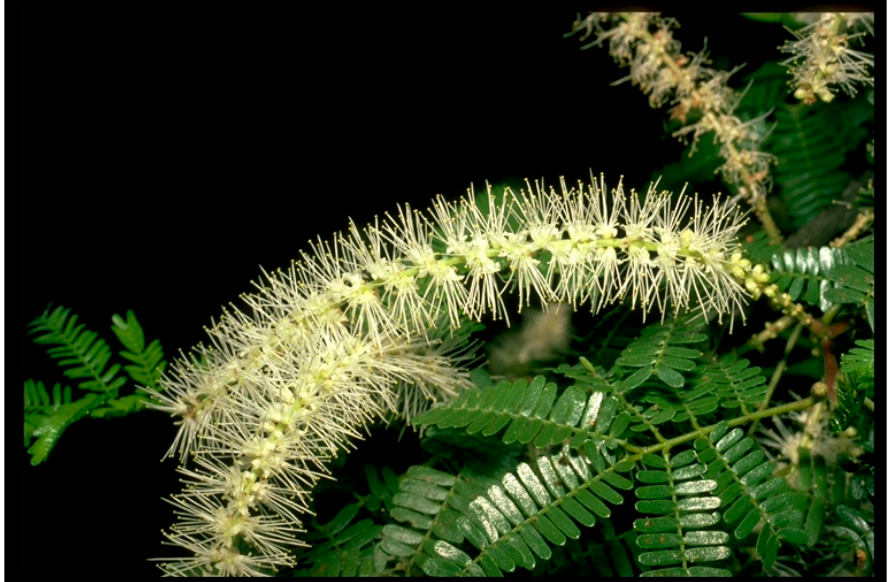
Figure 6. Photo of Mimosa tenuiflora (Willd.) Poiret (copyright held by Royal Botanical Gardens,